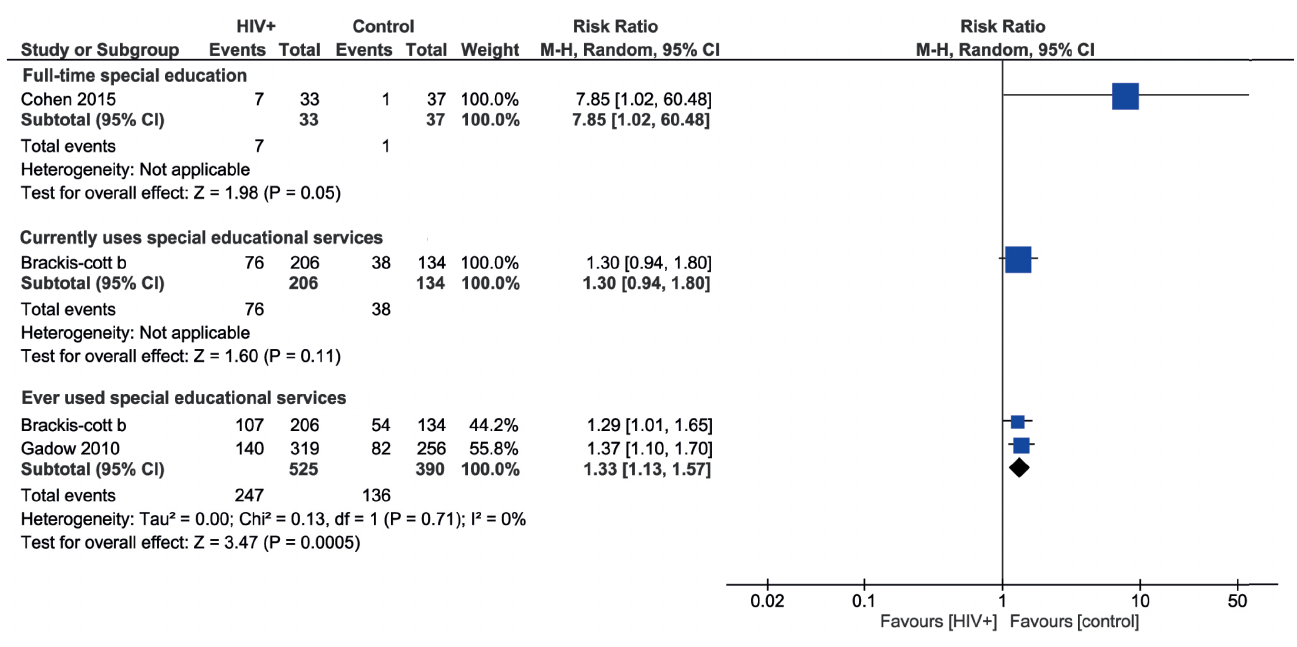
Fig 2. Special educational services used by HIV-infected children compared to control